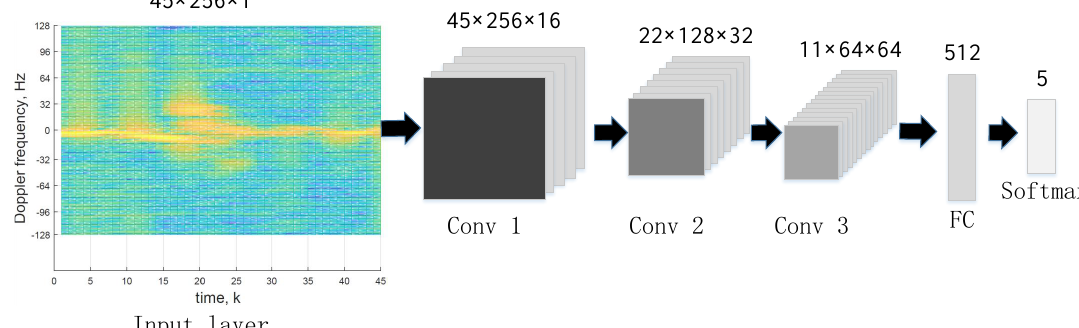
Figure 7. The network architecture of our recognition model.